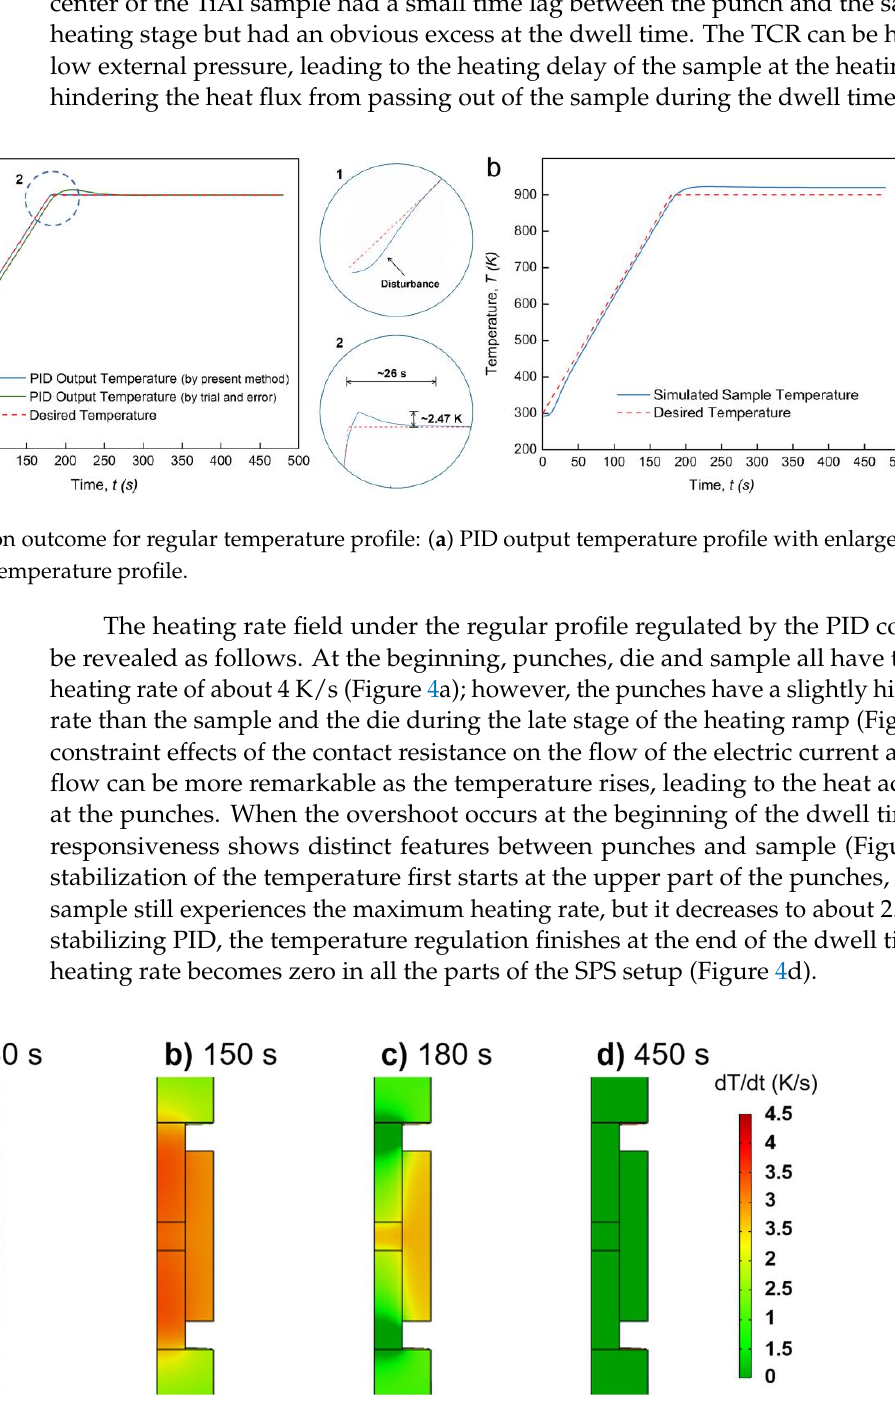
Figure 5. PID regulation outcome for continuous temperature profile: ( a ) PID output temperature profile with enlarged views; ( b ) simulated sample temperature profile.